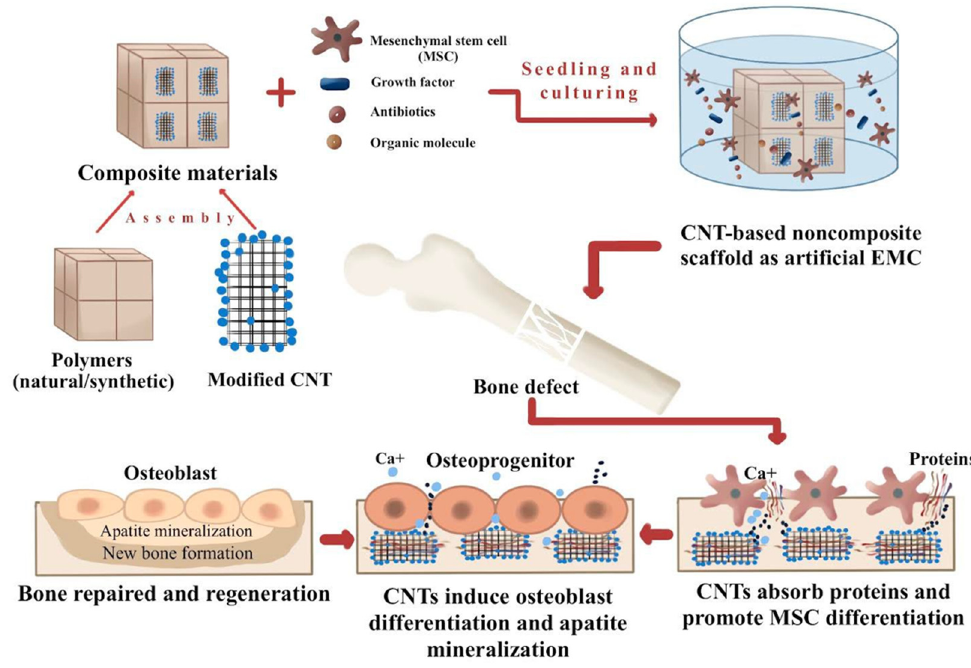
Figure 1. The process of bone regeneration using MSCs.